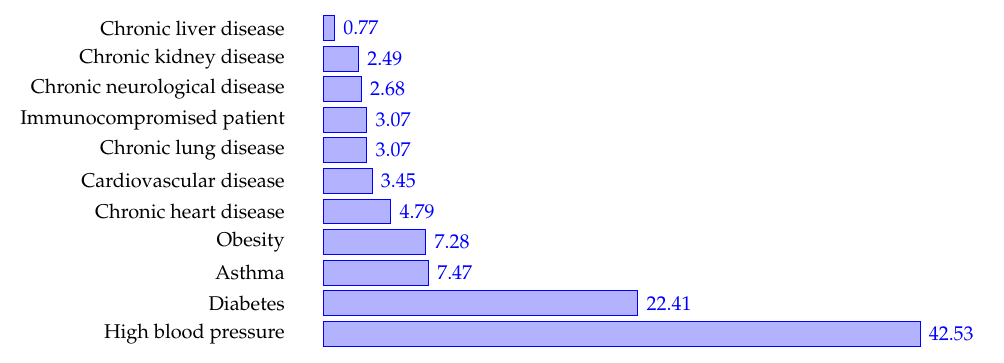
Figure 5. Comorbilities frequency.